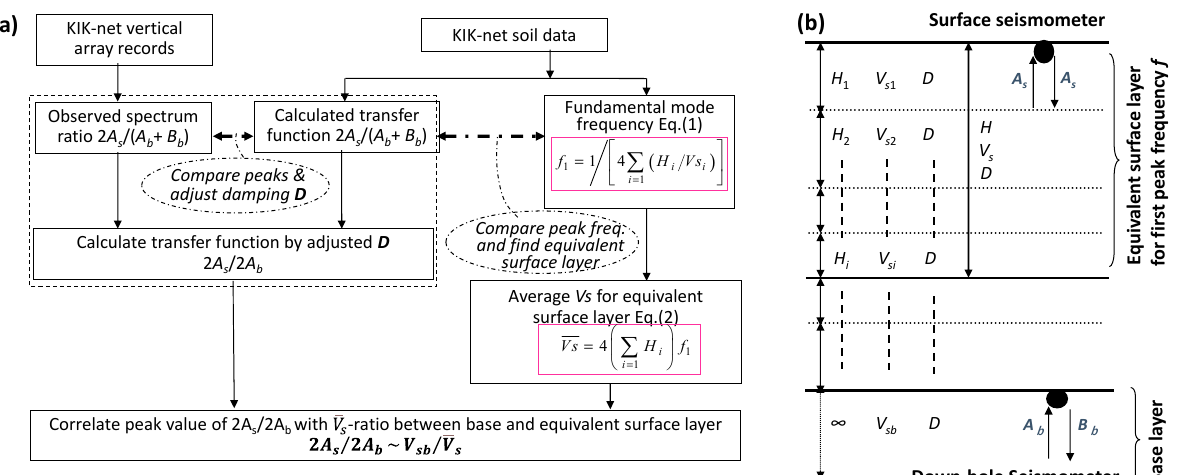
Figure 9. Flow chart developing amplification versus V s -ratio correlation based on vertical array database ( a ), and concept for equivalent surface layer for first peak frequency ( b ).